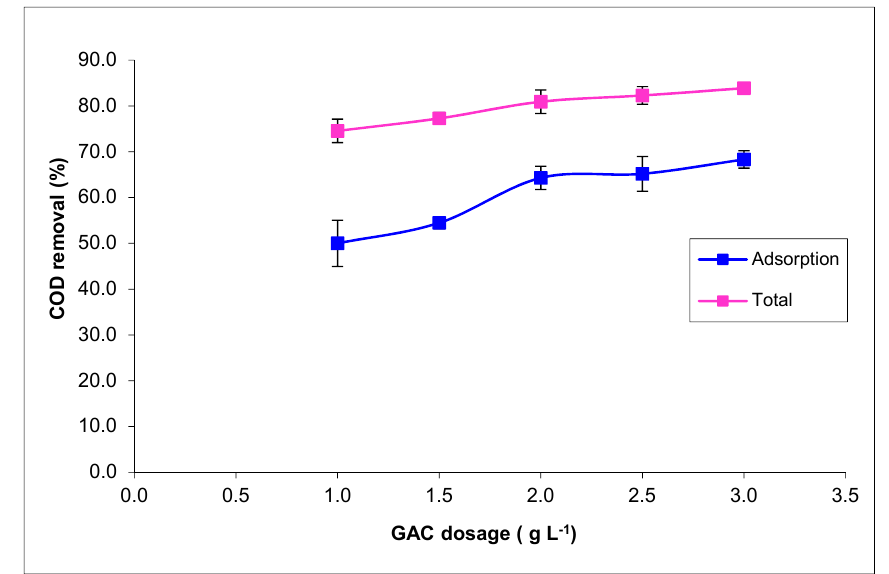
Figure 2. Effect of granular activated carbon dosage on COD removal.